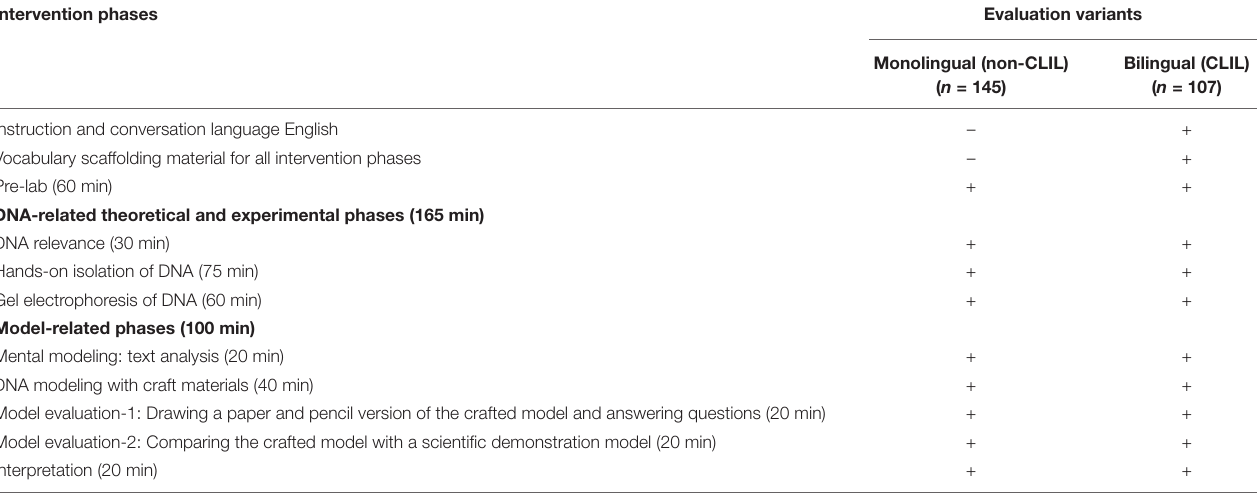
TABLE 1 | Quasi-experimental intervention design [adapted from Roth et al. (2022)]. Intervention phases